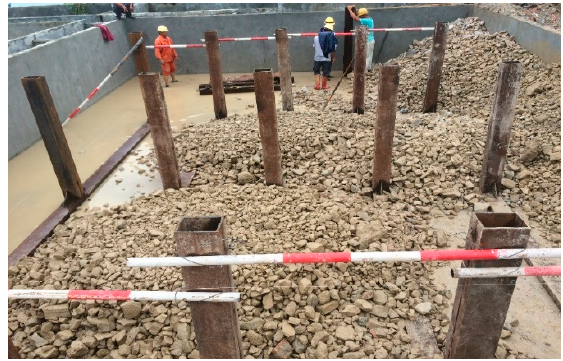
Figure 3. The pre-placed reaction frame.